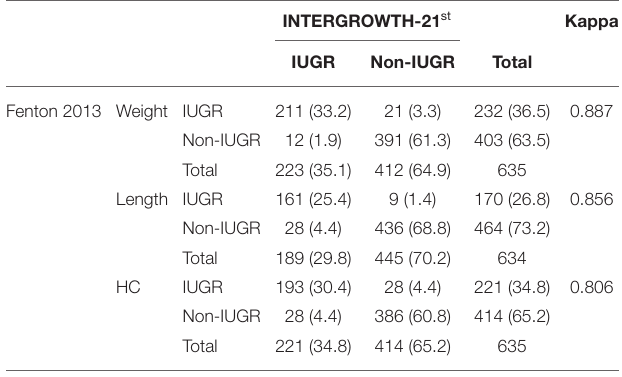
TABLE 2 | IUGR comparison using Fenton and IW-21 (weight, length, and head circumference).